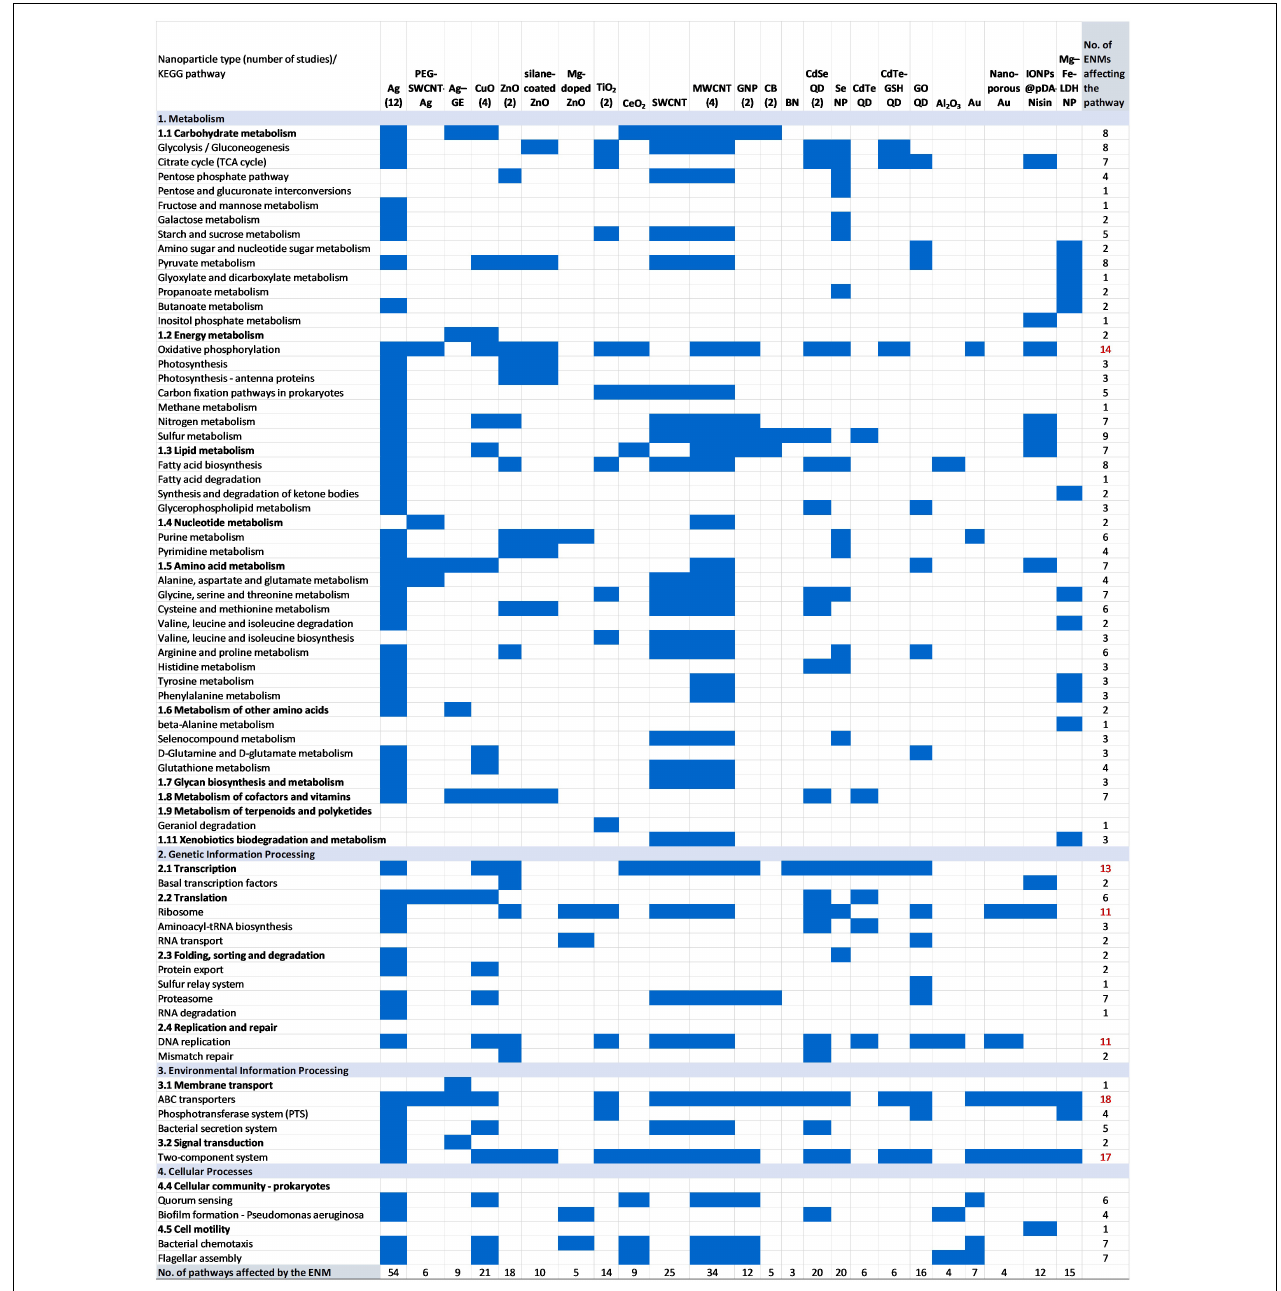
FIGURE 1 | Affected KEGG pathways in bacteria upon exposure to engineered nanomaterials (ENMs) based on 40 published studies using omics analyses ( Supplementary Table 2 ). Forty studies resulted in 46 entries since some papers regarded more than one ENM type. If the ENM was assessed in more than one study, the number of papers is indicated in parentheses after the ENM type. For KEGG pathways that were affected by more than 10 ENMs, the number of ENMs is indicated in red (rightmost column). PEG-SWCNT-Ag, pegylated Ag-coated single-wall carbon nanotubes; Ag-GE, Ag nanoparticle–graphene nanocomposites; MWCNTs, multiwall carbon nanotubes; GNP, graphene platelets; CB, carbon black; BN, boron nitride; CdSe QD, CdSe quantum dots; CdTe GSH QD, CdTe glutathione quantum dots; IONPs@pDA Nisin, nisin-loaded iron oxide nanoparticle polydopamine composites; Mg–Fe-LDH NPs, Mg–Fe layered double hydroxide